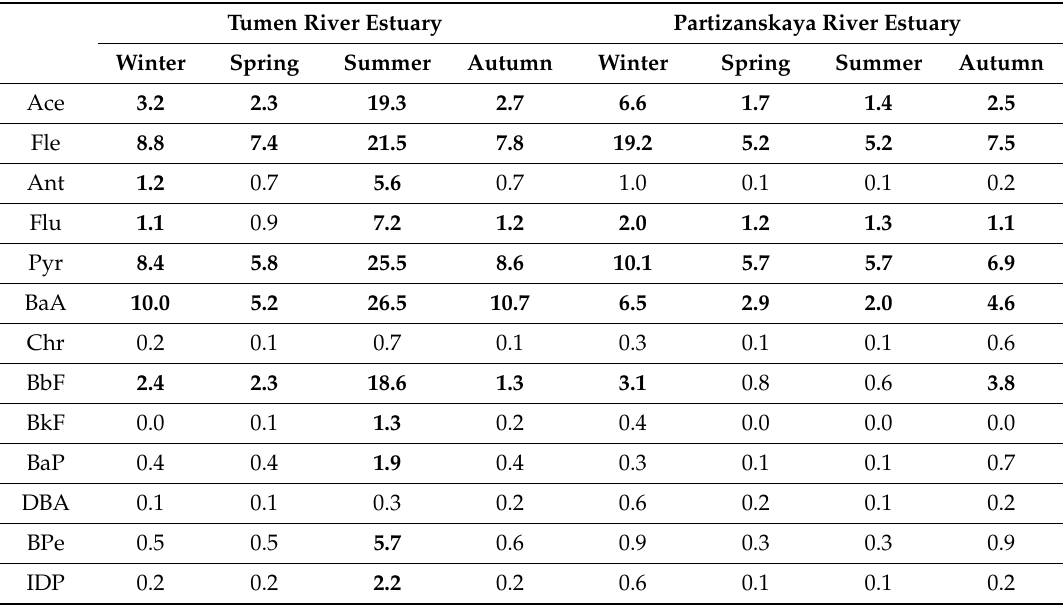
Table 3. Mean RQ NCs values for individual PAHs in the